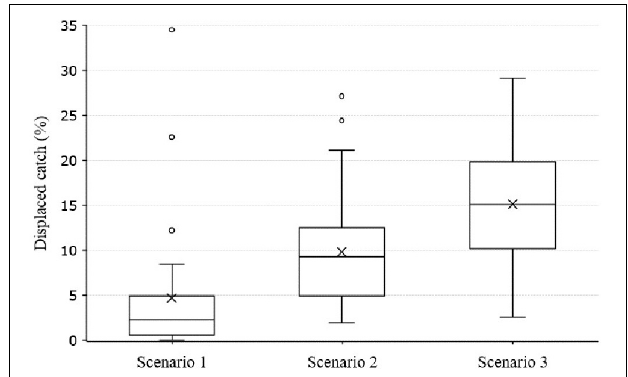
FIGURE 5 | Displaced catch per Zonation scenario at 30% ocean protection. Only exploited species that form the majority of global catch were included due to their importance to food security (50.1% of catch by weight, 38 of 2165 exploited species). Mean displaced catch in Scenario 1, 4.6%; Scenario 2, 9.8%; Scenario 3,